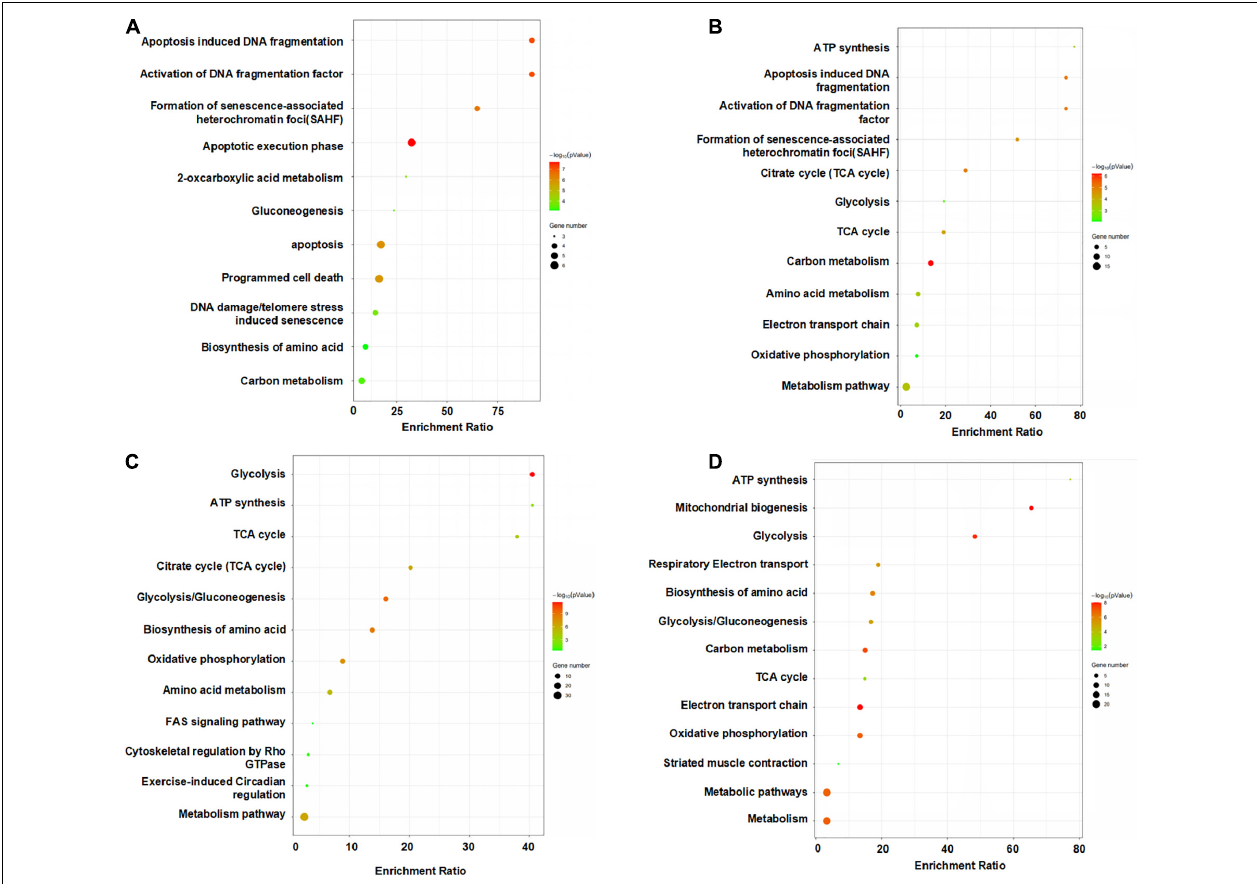
FIGURE 7 | Pathway analysis of the differentially expressed proteins from the MSCs in HLI vs. Sham at each time points. KEGG enrichment analyses of DEPs from the MSCs in HLI vs. in Sham hindlimb at days 1 (A) , 3 (B) , 7 (C) , and 14 (D) . KEGG pathway analysis of DEPs indicated a remarkable difference in cellular functions between HLI and Sham. Bubble graphs describe the distribution of DEPs in a classified KEGG pathway. The bubble size represents the differential protein expression level. The red bubbles show that the protein level in HLI is higher than that in Sham, whereas the green bubbles show the opposite